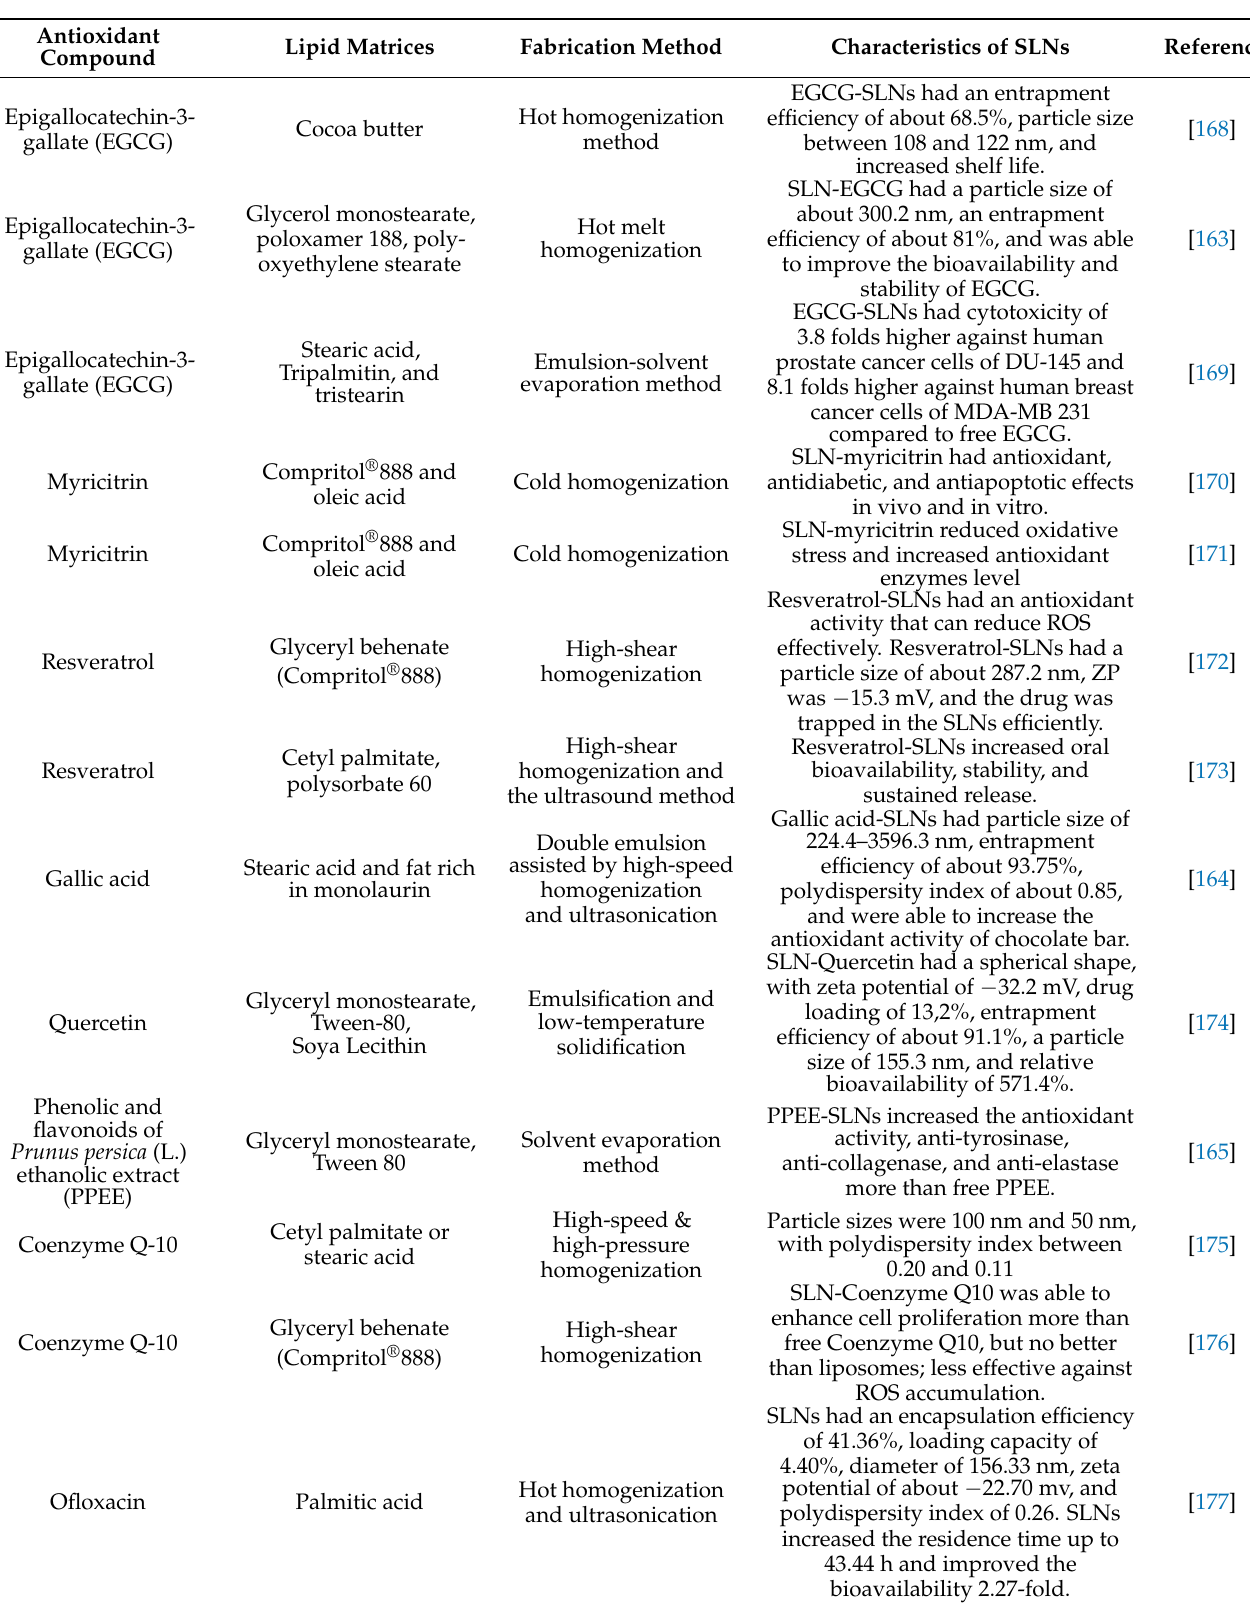
Table 6. Application of SLNs for the Encapsulation of Polar and Semipolar Antioxidant